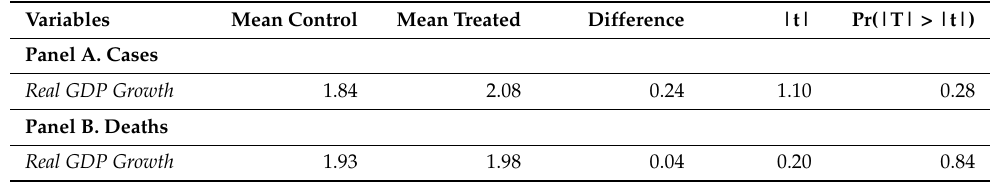
Table A2. Test of Parallel